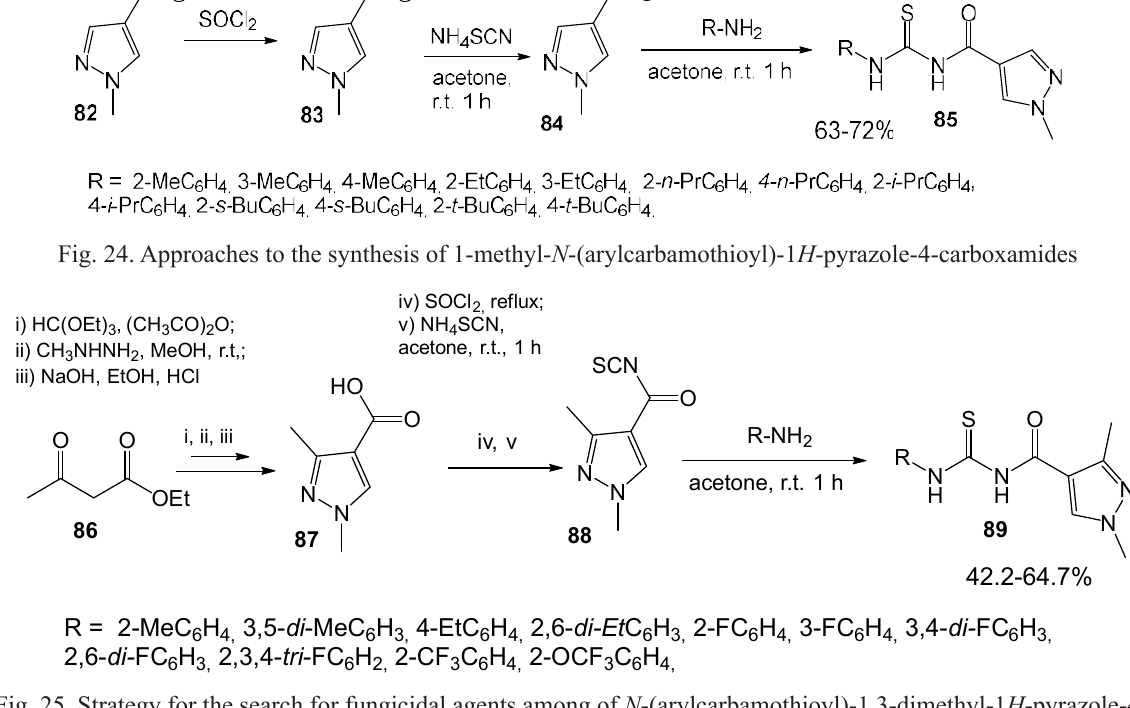
Fig. 25. Strategy for the search for fungicidal agents among of N -(arylcarbamothioyl)-1,3-dimethyl-1 H -pyrazole-4-